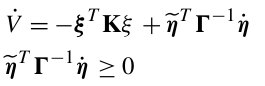
Figure 5. Block diagram representation of the proposed robust task-space control